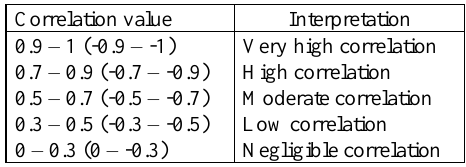
Table 1 . Interpretation of Correlation Values